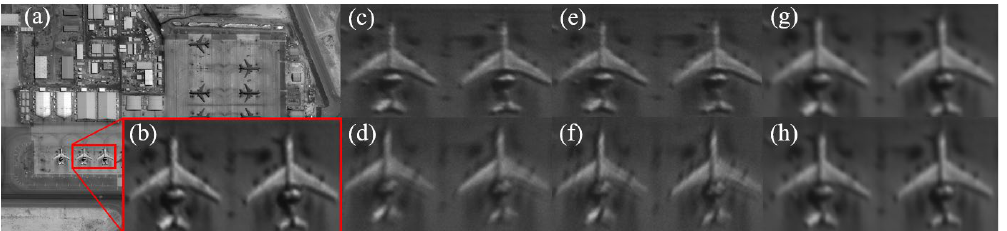
Figure 11. Simulation results when the pupil’s length–width ratio is 3. ( a ) Original scene, ( b ) real image taken by the circular primary mirror, ( c ) real image when the angle of rotation is 0°, ( d ) real image when the angle of rotation is 90°, ( e ) simulation image obtained by the CCNN when the angle of rotation is 0°, ( f ) simulation image obtained by the CCNN when the angle of rotation is 90°, ( g ) simulation image obtained by the PSF-conv method when the angle of rotation is 0°, and ( h ) simulation image obtained by the PSF-conv method when the angle of rotation is 90°.